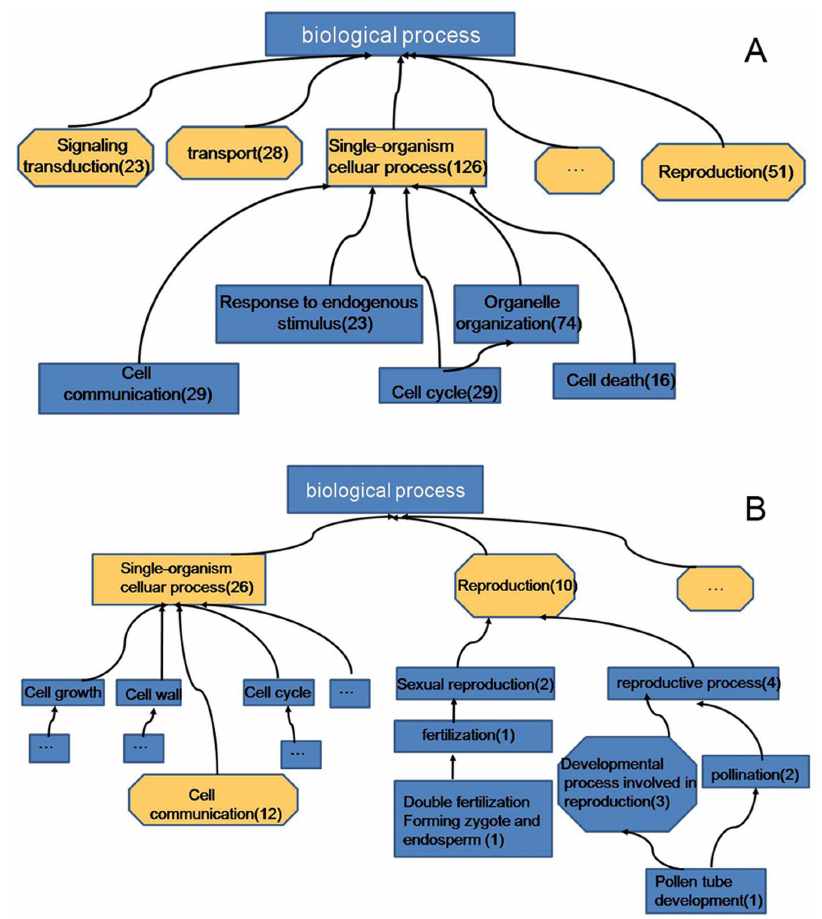
Figure 7. Biological process pathways.